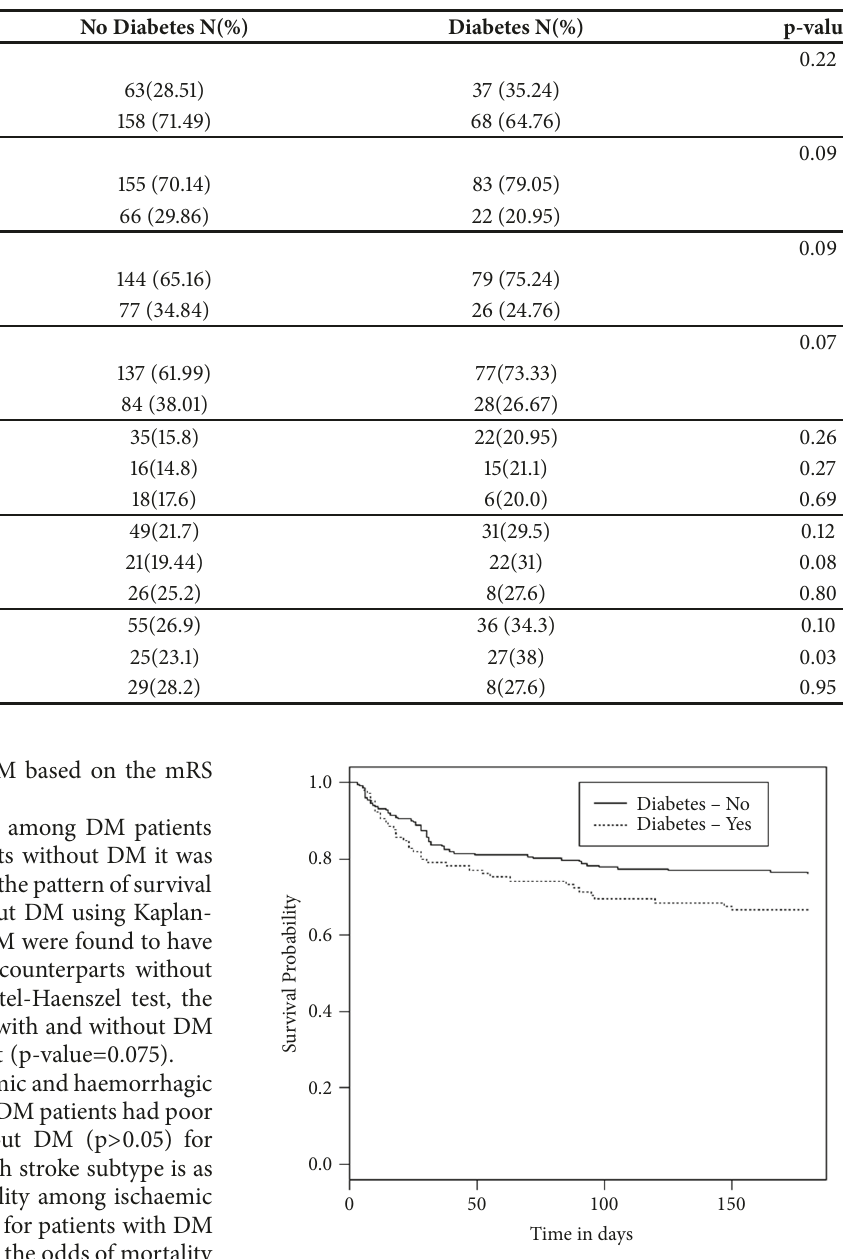
Table 2: Severity of neurological impairment and stroke outcome versus diabetes status.